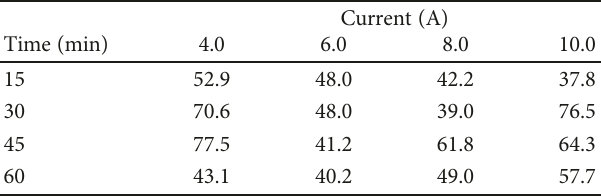
Table 3: Removal e ffi ciency of COD mg · L − 1 by di ff erent